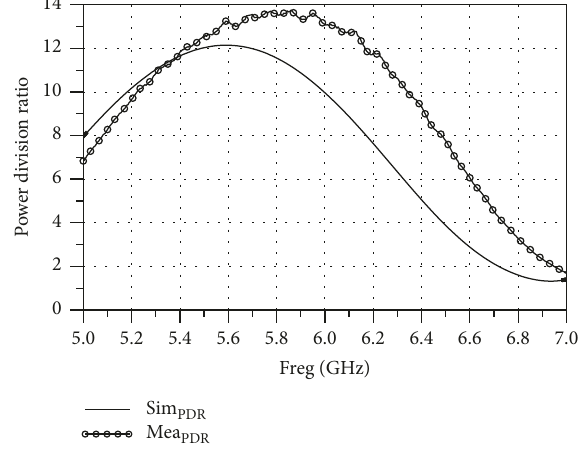
Figure 12: Comparison of power division ratio (PDR) between the electromagnetic simulation in ADS and measurement. The measured PDR is 13.59 at